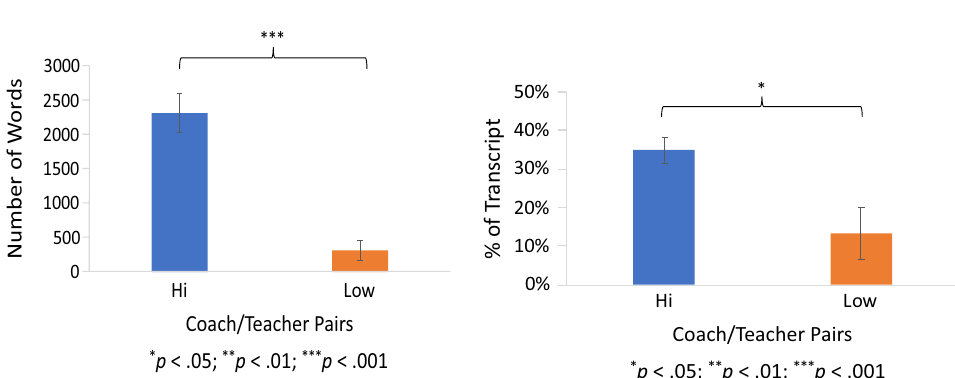
Fig. 2 Mean (and SE bars) per coach–teacher conference by high- vs. low- growth pairs (along with statistical significance of the group contrast) in the A total amount of teacher and coach talk (in words) and B percent of each conference transcript, that is contained within a